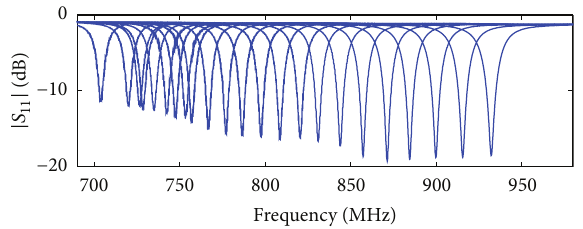
Figure 13: Measured tuning range of the demonstrator in Figure